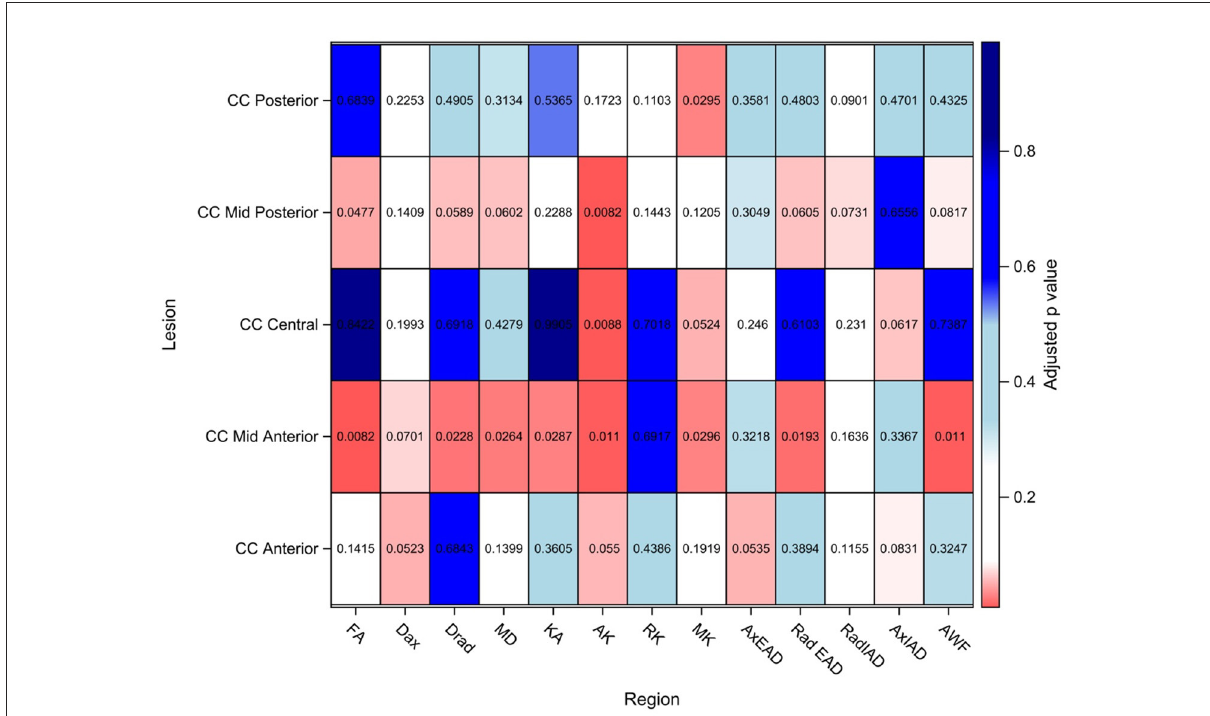
FIGURE3 DTI/DKI/WMTI findings in the segments of corpus callosum. Values shown here are adjusted p -values after adjusting for multiple comparison. Adjusted p -value < 0.10 is considered to be statistically significant in this exploratory study to identify potential signals. FA, Fractional anisotropy; Dax, axial diffusivity; Drad, radial diffusivity; MD, mean diffusivity; KA, kurtosis anisotropy; AK, axial kurtosis; RK, radial kurtosis; MK, mean kurtosis; AxEAD, axial extra-axonal diffusivity; RadEAD, radial extra-axonal diffusivity, RadIAD, radial intra-axonal diffusivity; AxIAD, axial intra-axonal diffusivity; AWF, axonal water